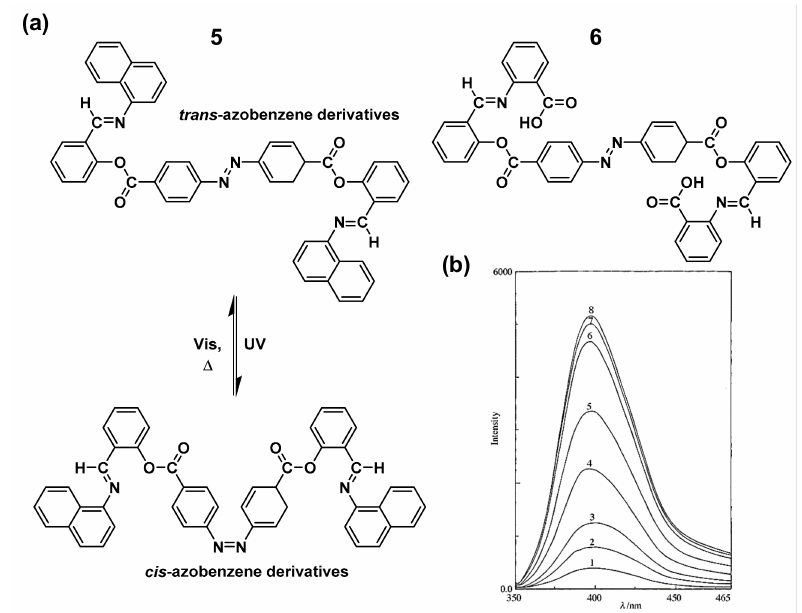
Figure 6. ( a ) The molecular structure of 5 and 6 . ( b ) The corrected emission spectra of 5 as a function of irradiation time for forward E → Z process: (1) before irradiation; (2) irradiation for 5 min; (3) 15 min; (4) 30 min; (5) 45 min; (6) 60 min; (7) 75 min; (8) 115 min. ( b ) was reproduced with permission from [59]. Copyright 1998 The Royal Society of Chemistry.